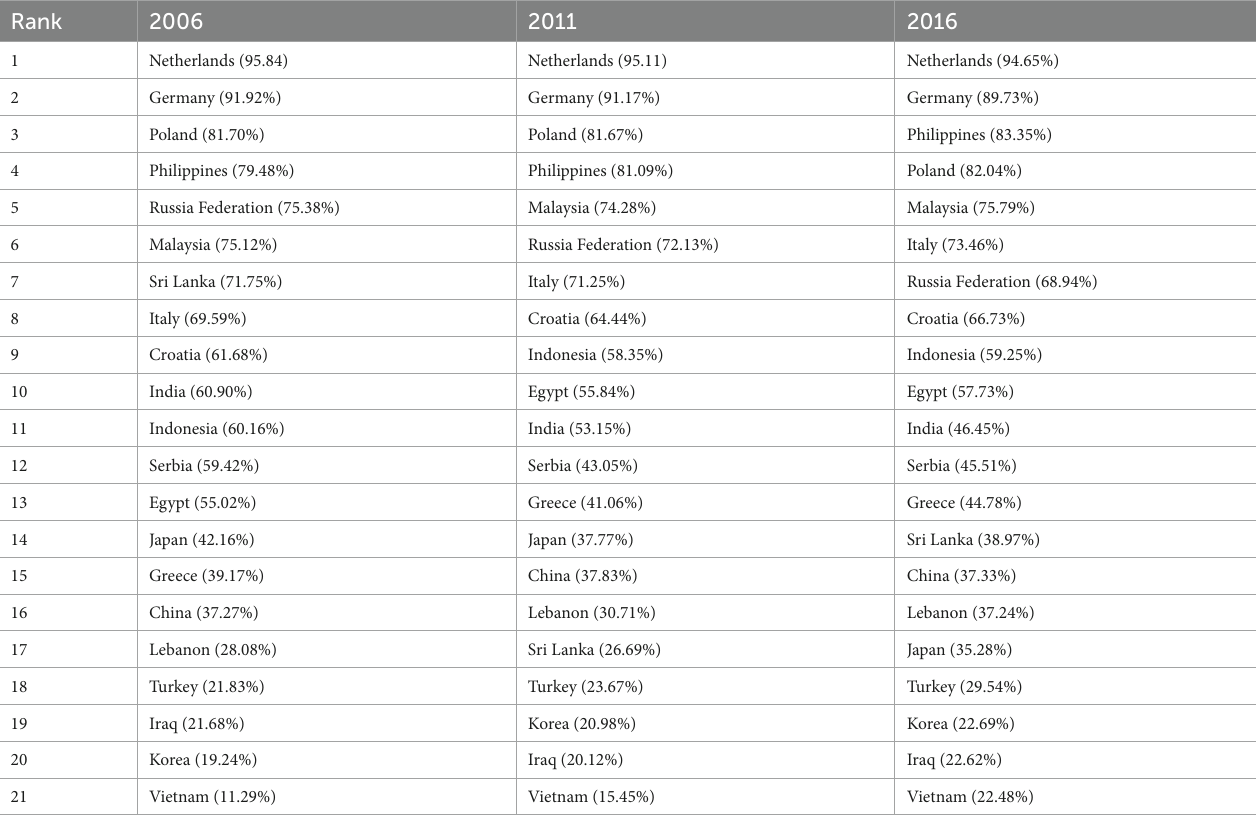
TABLE 5 Language shift of the second generation by ancestry in 2006, 2011, and 2016.